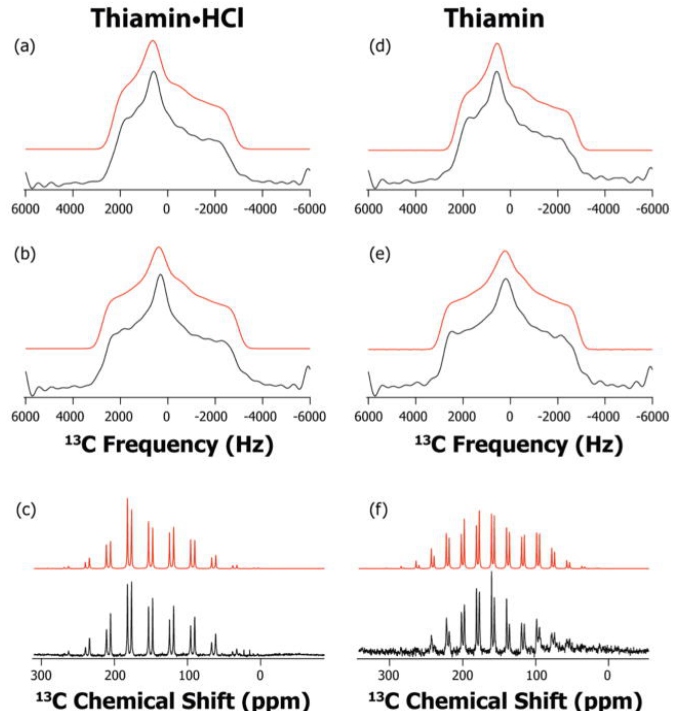
Figure 1. 13 C ROCSA and slow-MAS spectra of Th•HCl and Th: experimental (black) and simulated (red). ( a ) ROCSA spectrum of C2 of Th•HCl; ( b ) ROCSA spectrum C6 ′ of Th•HCl; ( c ) slow-MAS spectrum C2 and C6 ′ of Th•HCl at 2900 Hz rotor frequency; ( d ) ROCSA spectrum of C2 of Th; ( e ) ROCSA spectrum of C6 ′ of Th; and ( f ) slow-MAS spectrum of C2 and C6 ′ of Th at 2075 Hz rotor frequency [46]